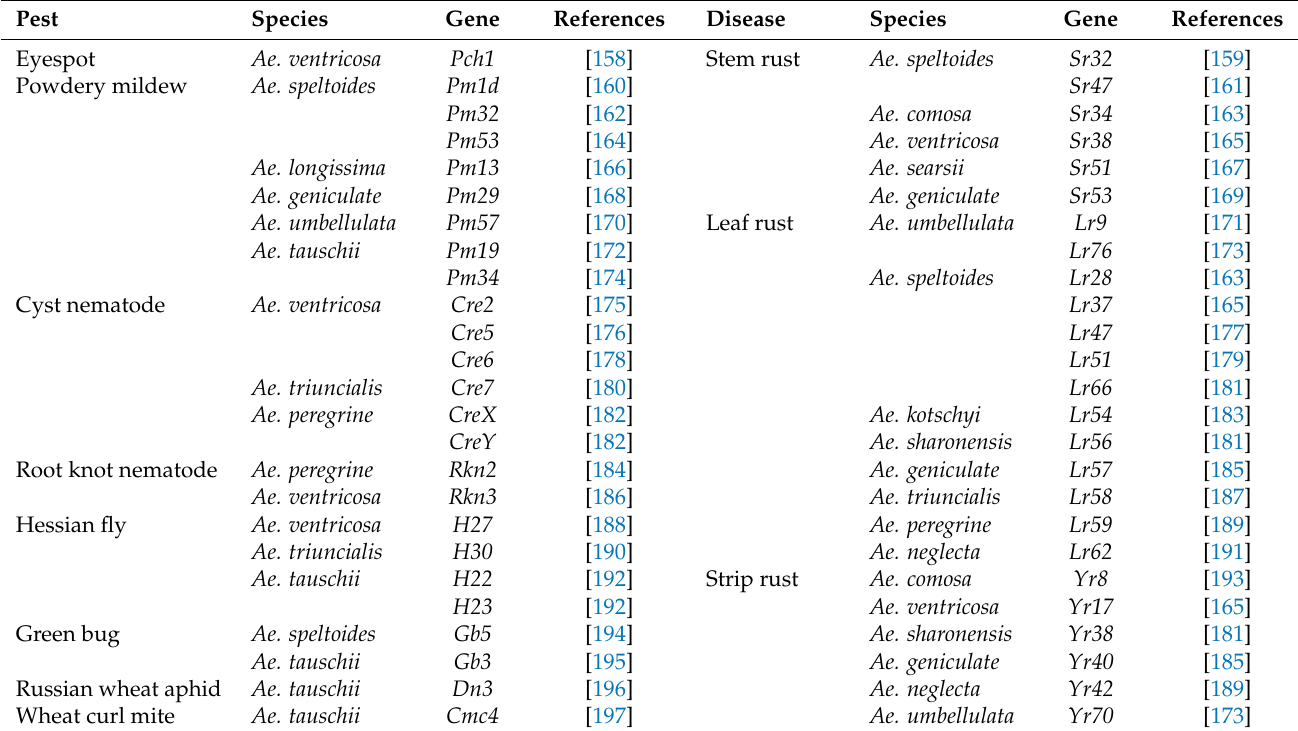
Table 5. Identified or transferred resistance genes from various Aegilops species into bread